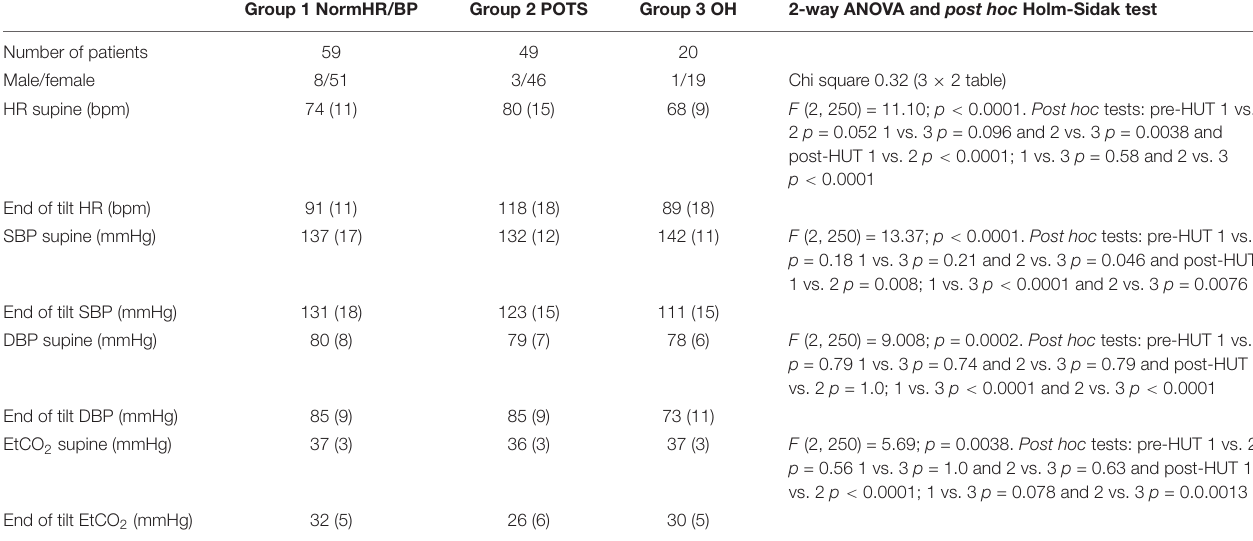
TABLE 2 | Hemodynamic responses during HUT of the study population. Group 1 NormHR/BP